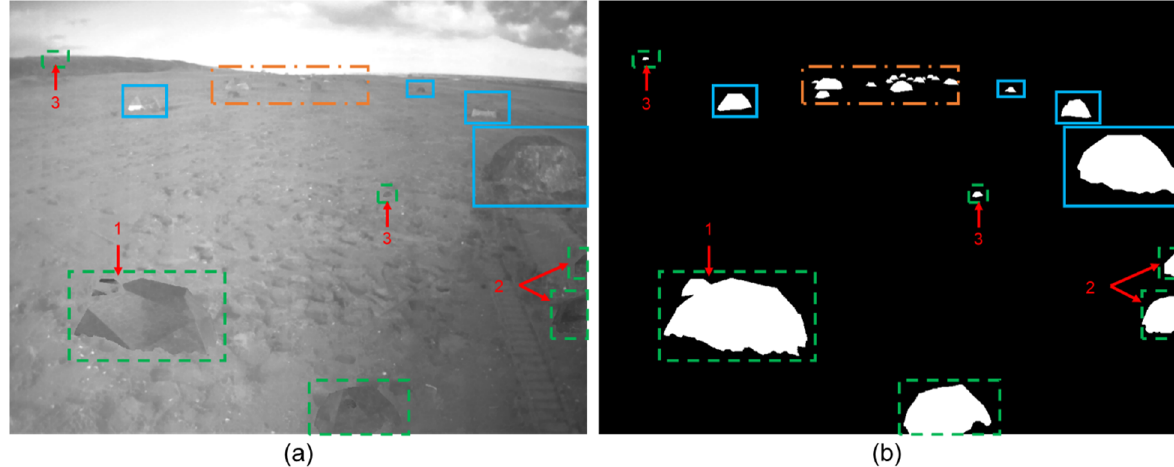
Figure 6. A typical example in the synthetic dataset. ( a , b ) refer to the synthetic image (from the proposed synthetic algorithm) and the simultaneously generated annotation. Blue solid frames, green dash frames, and orange dot-dash frames refer to original rocks, embedded synthetic rocks, and un-highlighted rocks, respectively. The reason for the un-highlighted rocks is their small and dense distribution, which can cause a bad visualization. “1”, “2”, and “3” highlight the complex cases of occlusion, unclosed outline, far, and small target, respectively. ( b ) uses white pixels to refer to the rocks, while black pixels refer to the background.